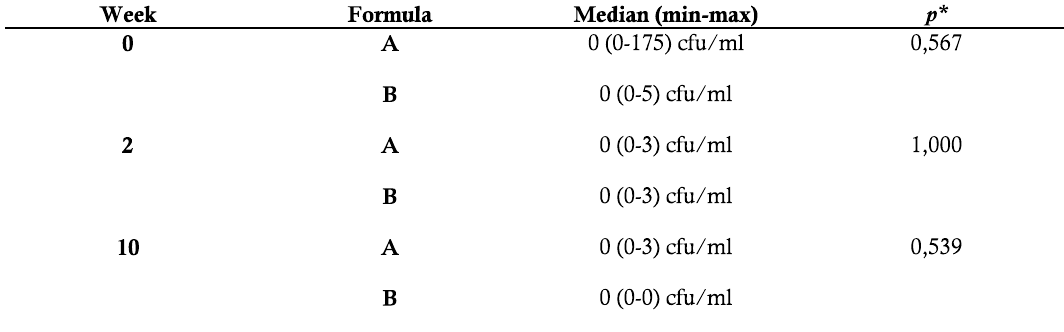
Table 2. The effectiveness of WHO Formula A and B